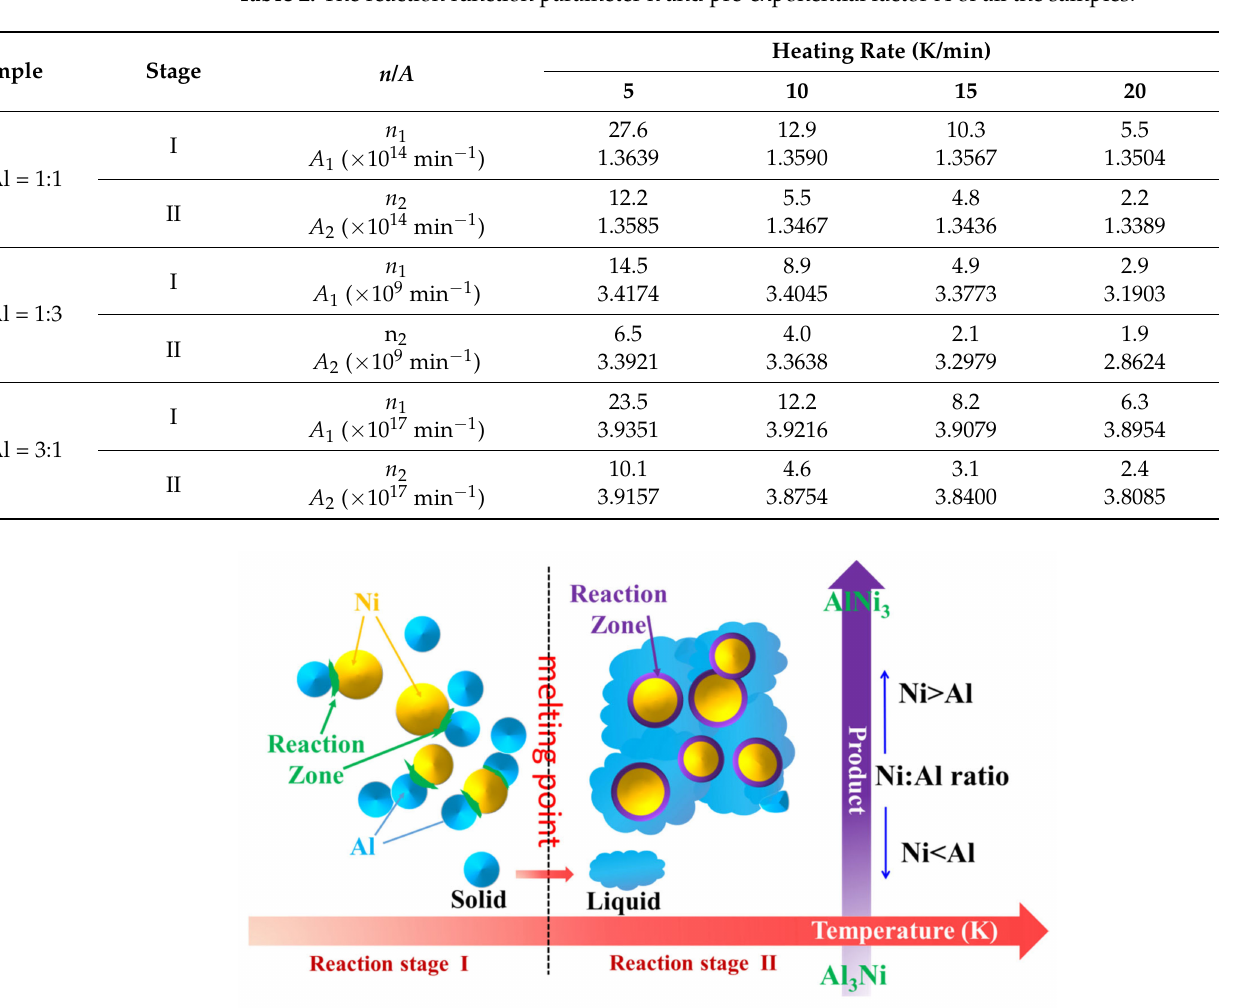
Table 2. The reaction function parameter n and pre-exponential factor A of all the samples.